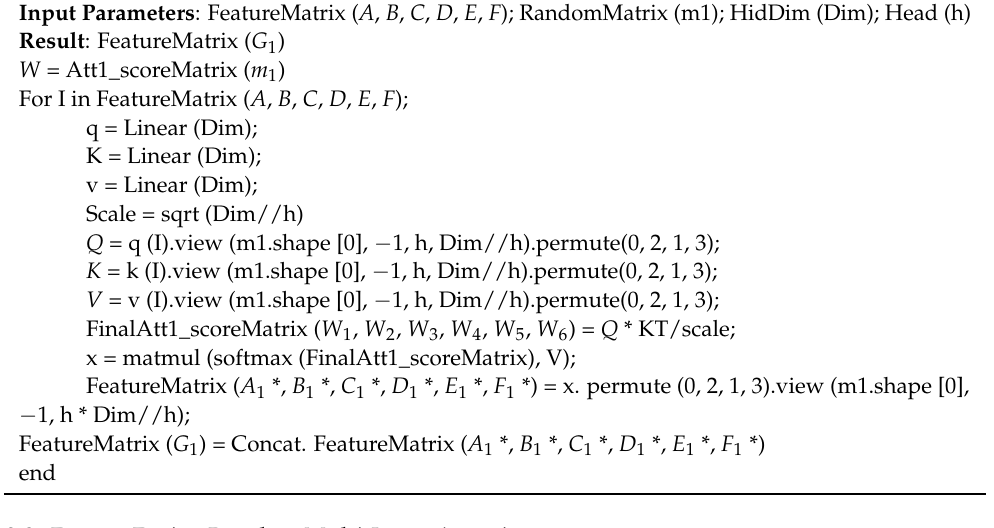
Algorithm 1: Feature Extraction Based on Single-Layer